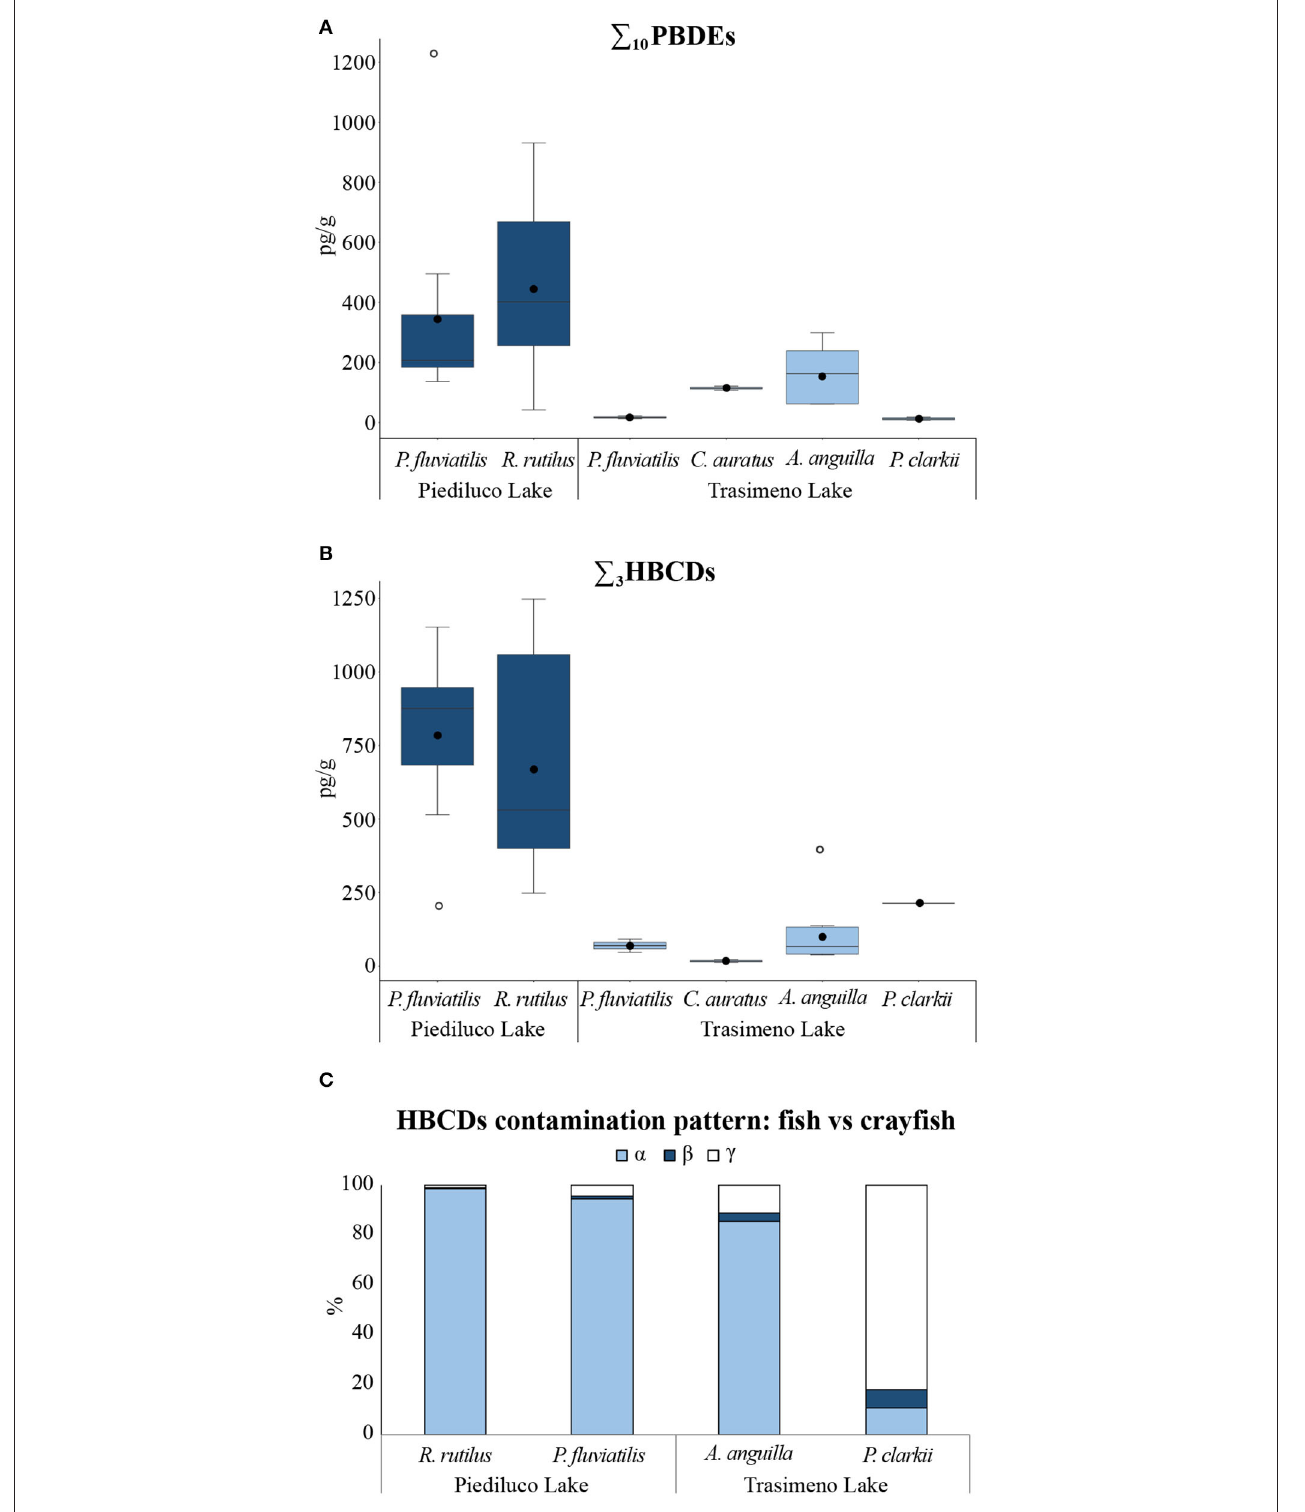
FIGURE 4 | (A) Box plots of (A) P 10 PBDEs concentrations (pg/g) and (B) P 3 HBCDs concentrations (pg/g), in muscle of fishes and in whole soft body of crustaceans sampled in Piediluco and Trasimeno lakes (Italy): the plots depict the lower, median, upper quartile observation, any outliers (empty circles), and mean values (full circles) in the data set; the extensions (“whiskers”) at either ends of the box indicate the minimum and maximum values; (C) HBCDs contamination patterns (abundance ratio for the α -, β -, γ -HBCD isomers) between fishes and crayfishes sampled in Piediluco and Trasimeno lakes (Italy).